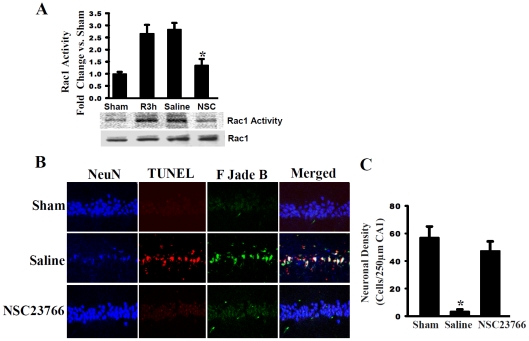
Rac GTPase Activation Contributes Significantly to Neuronal Cell Death in the Hippocampus CA1 Region Following Global Cerebral Ischemia (GCI).(A) NSC23766 significantly attenuated cerebral ischemia-induced Rac1 activity at 3 h after ischemia. *Represents P<0.05 (four to 5 animals) vs. reperfusion 3 hour (R3h) and saline treatment groups. (B) Representative hippocampal CA1 sections from sham, saline–treated (ischemia) and NSC23766-treated (ischemia) male rats were labeled with NeuN (Blue), TUNEL (Red) and FJadeB (Green) staining at 7 d following GCI. Merged images represent CA1 neurons undergoing degeneration, indicated by white staining. (C) Quantification showed that NSC23766 was strongly neuroprotective of CA1 region. Data was obtained from five independent animals and a typical experiment is presented. Results are expressed as neuronal density with mean ± SE. *
p<0.05 vs. sham control and NSC23766.